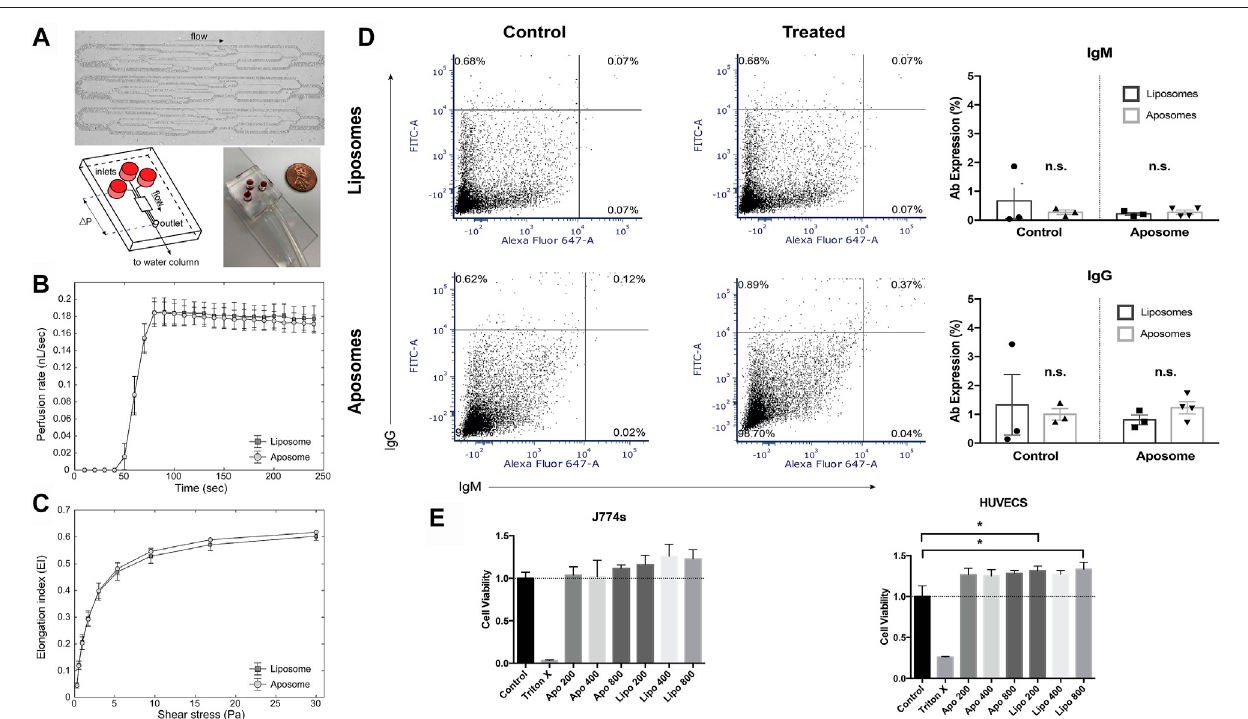
FIGURE4| Aposomesshowafavorablebiocompatibility (A) TheAMVNmicro fl uidicdeviceconsistsofthirty-four5 µmdeepmicrochannelsranginginwidthfrom5 to 70 µm (to mimic arteriolar to capillary vessel size). Each AMVN has three networks connected to its independent inlet and a single common outlet that allows for the measurement of three separate samples in parallel (B) The AMVN perfusion rate was measured for RBCs incubated with liposome (control; n (cid:2) 3) and aposome (n (cid:2) 3). For each AMVN device, one liposome and two aposome samples were measured, allowing for three liposome-treated sample measurements and six aposome- treated measurements per RBC unit and nine liposome-treated measurements and eighteen aposome-treated measurements in total. The plateau regions of perfusion rateswereaveragedtoyieldthevaluesofthemeanperfusionrate(liposome:0.18 ± 0.01 nL/s;aposome:0.18 ± 0.01 nL/s).Thedifferencesbetweenbothgroups ’ mean AMVN perfusion rates were not statistically signi fi cant (paired t -test two-tailed; p > 0.05) (C) RBC deformability was also measured using conventional ektacytometry. RBC ’ s treated with either liposome or aposome underwent a range of shear stresses while ektacytometry measured elongation index (EI). The EI was not signi fi cantly different between the two groups for all shear stresses applied (paired t -test two-tailed; p > 0.05) (D) Mice injected with aposomes show no signs of immunogenicity as measured in the formation aposome-speci fi c of acute or chronic antibody response as measured using fl ow cytometry (E) In-vitro analysis of toxicity shows no decreased viability in J774 macrophages or HUVECs (human umbilical cord endothelial